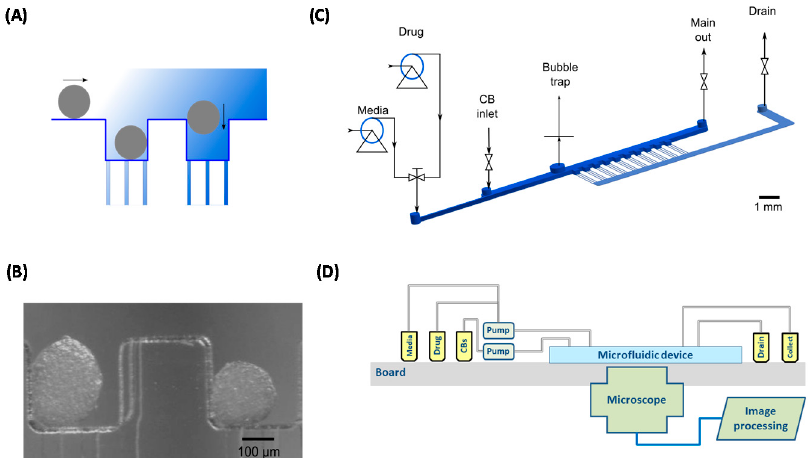
Figure 9. ( A ) Functional components required for a design of a MBR with cardiac cells based on the functional subsystems in Figure 7. ( B ) Two possible configurations of these functional components. ( C ) A comparison of the two configurations with the user needs in Table 4 in which scores are calculated for weight factors (all of which are 100%) or as shown in last column in the table.